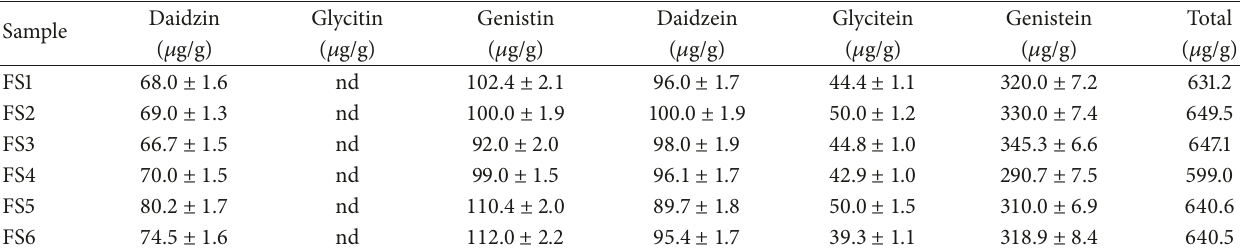
Table 3: Concentrations of isoflavones estimated ( 𝑛 = 3 ) in the selected soybean flour samples. Sample